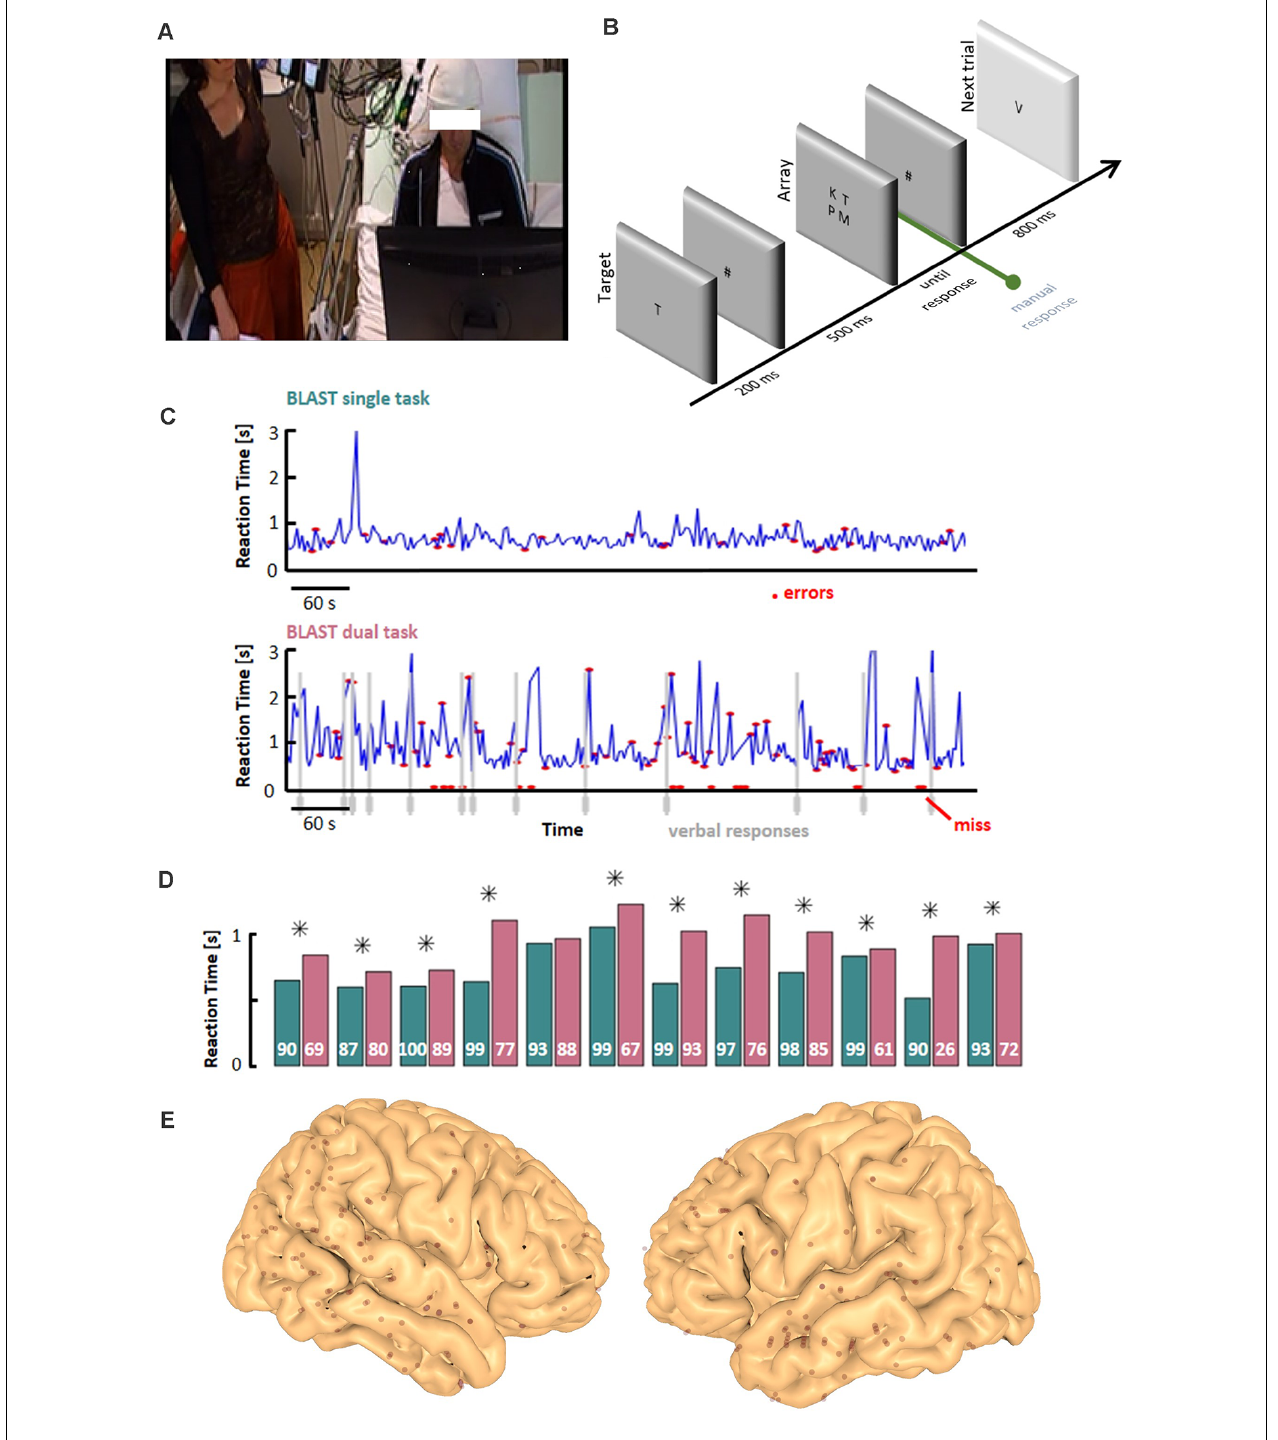
FIGURE 1 | Experimental design. (A) Dual-Task set-up: the experimenter is standing or sitting at the bedside, in the peripheral visual field of the participant while the participant is performing BLAST (T1)—the verbal interaction is limited to a strict minimum, necessary for the VFT (T2). (B) Schematic depiction of T1 (see “Materials and Methods” section for details). (C) Example of behavioral performance during T1, in the Single-Task (ST) and Dual-Task (DT) conditions. The interference between the two tasks is clearly visible with slower and less accurate responses in the DT condition (vertical gray lines indicate VFT overt responses). (D) Mean reaction time during T1 for all participants, in the ST (teal) and DT (magenta) conditions (a star sign indicates a significant difference between the two conditions, two-sample t -test; p < 0.05). Accuracy is indicated in white (percentage of correct responses). (E) Entry points of iEEG depth-electrodes across all participants, projected onto the MNI-single subject brain template. VFT, Verbal Fluency